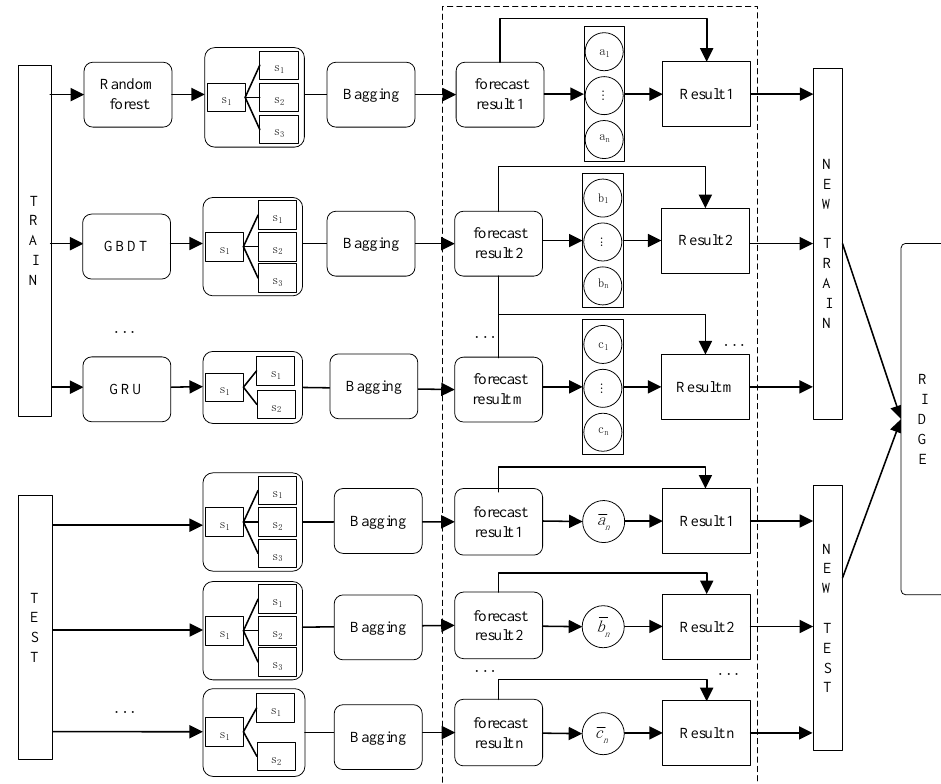
Figure 6. The meta learner test set adjustment process.